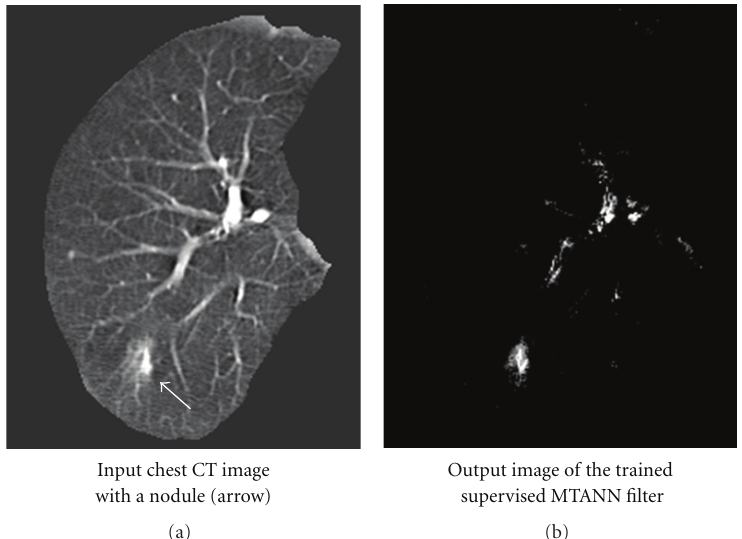
Figure 9: Enhancement of a lesion by use of the trained lesion-enhancement MTANN filter for a nontraining case. (a) Original chest CT image of the segmented lung with a nodule (indicated by an arrow). (b) Output image of the trained lesion-enhancement MTANN filter.